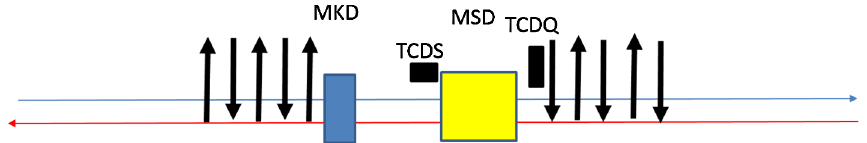
FIG. 2. Sketch of the dump concept. Arrows are indicating quadrupoles, MKD and MSD denote the extraction kicker and septum magnets, TCDS and TCDQ the protection absorbers for the septum and the quadrupoles,